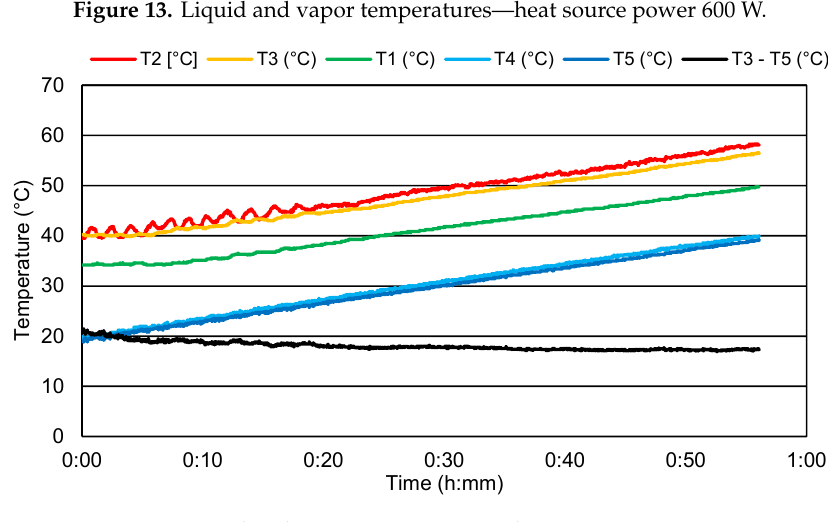
Figure 14. Liquid and vapor temperatures - heat source power 900 W.